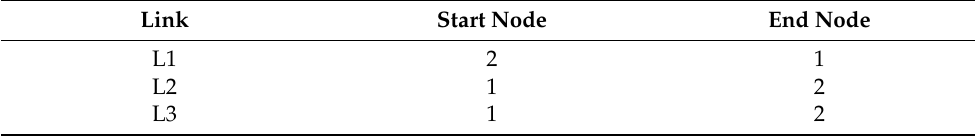
Table 2. Links and their connectivity matrix.